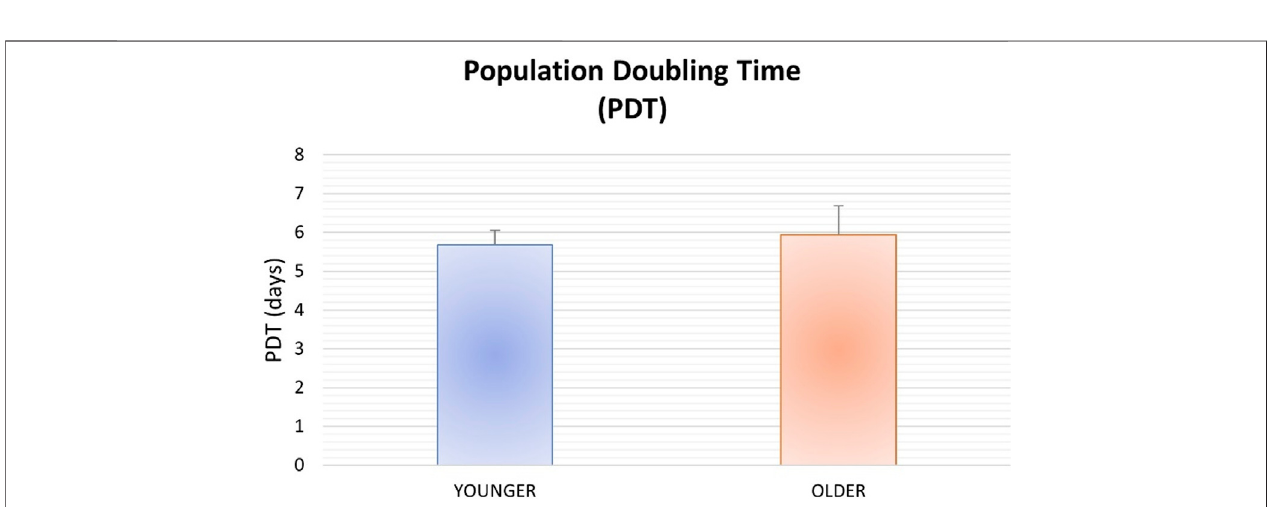
FIGURE 4 | Population doubling time for MSCs from BMAs clot for younger and older